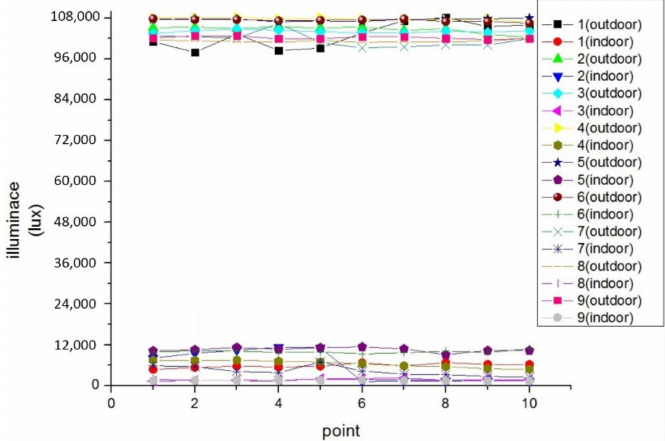
Figure 22. Results for the 10 measurements of outdoor and indoor illuminances.